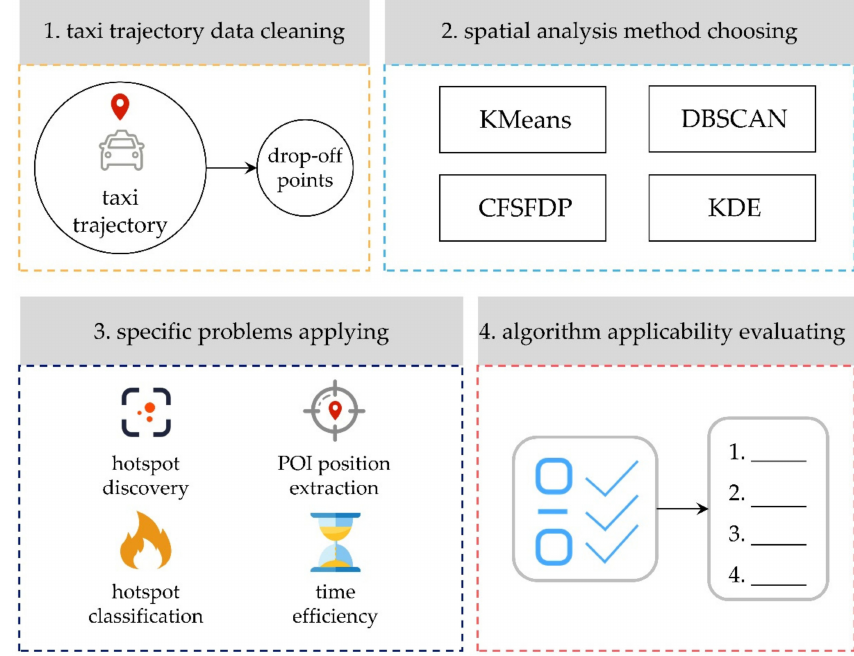
Figure 1. The framework of this